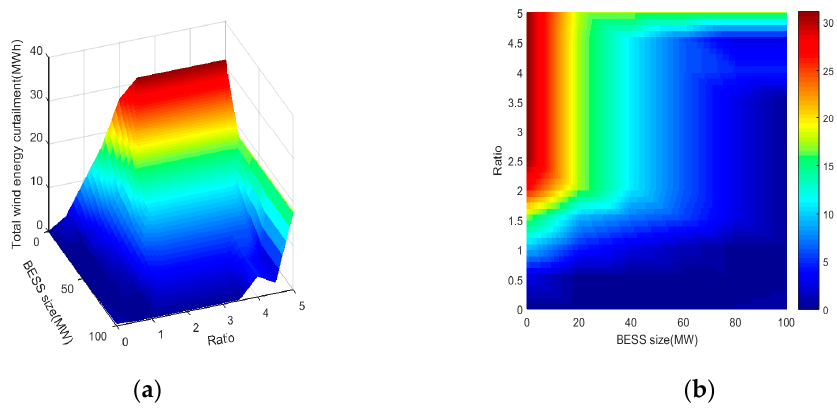
Figure 11. Effects of ratio ( β / α ) and BESS size on total wind energy curtailment during scheduling horizon: ( a ) Front view; ( b ) Top